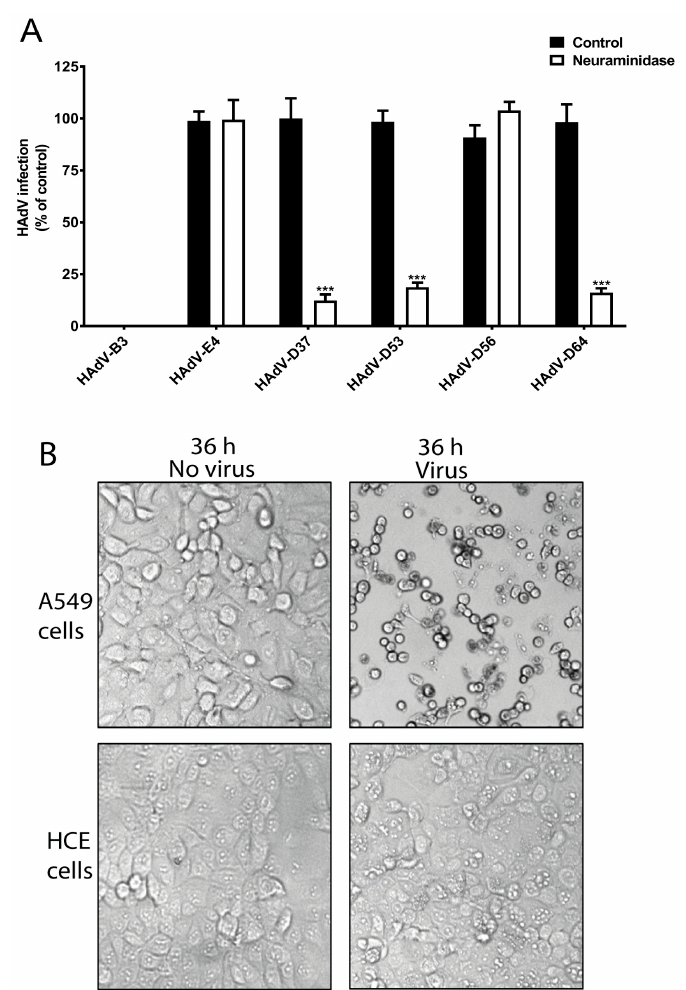
Figure 2. Infection of ocular HAdVs on neuraminidase pre-treated human corneal epithelial (HCE) cells. ( A ) HAdV-B3, -E4, -D37, -D53, -D56, and –D64 infection of HCE cells pre-treated with and without neuraminidase. ( B ) Cytopathic effect (CPE) analysis of HAdV-B3 on A549 and HCE cells. Error bars represent mean ± SEM. ***P < 0.001 relative to control.